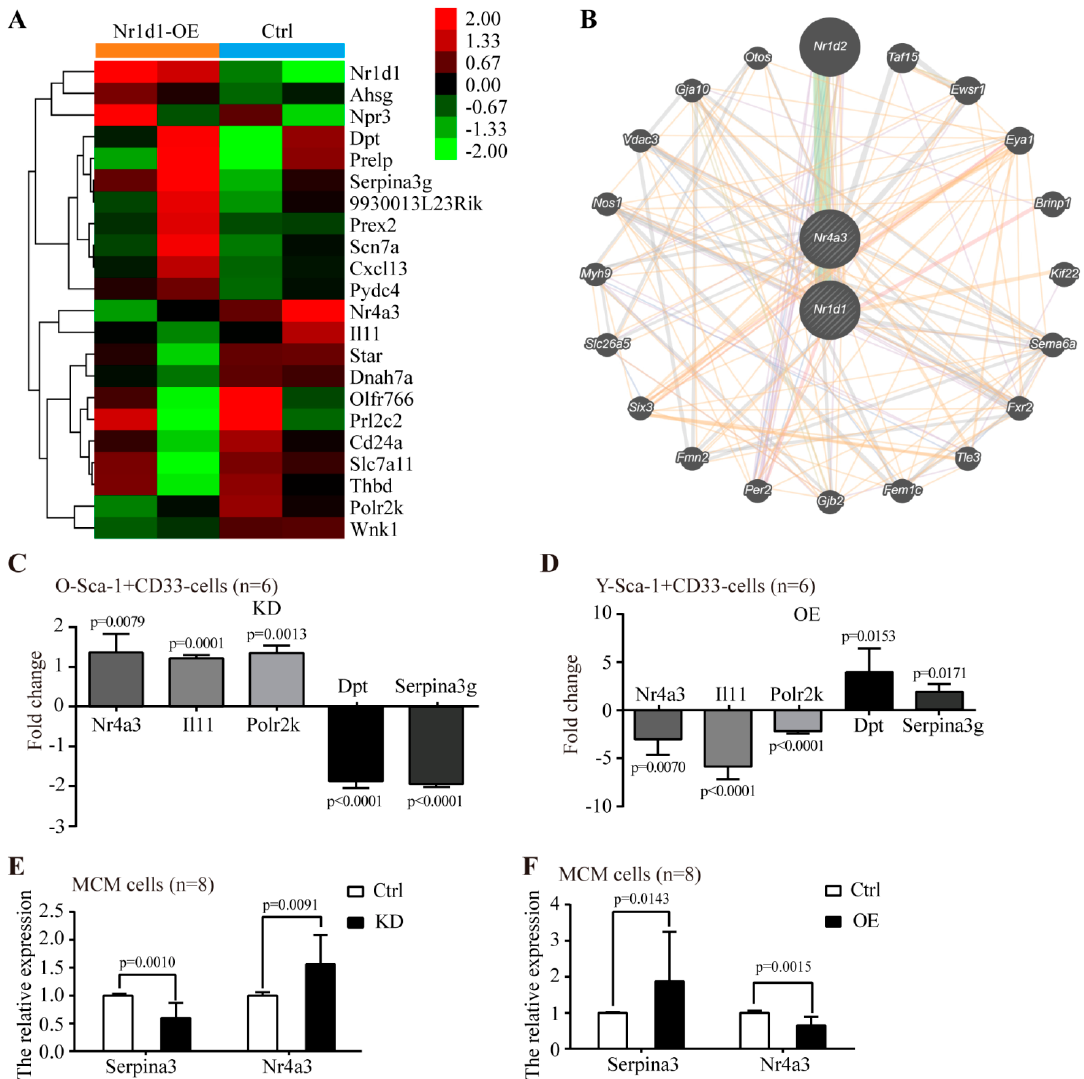
Figure 6. The effect of altered Nr1d1 expression levels on gene expression profiles. ( A ) the differ- entially expressed genes identified by a microarray in Young Sca-1 + CD31 − cells comparing the Nr1d1 -cDNA-infected cells and negative control. The tree was based on log2 transformation of normalized probe signal intensity using hierarchical clustering. Red: upregulated gene expression; Green: downregulated gene expression. Every sample was tested twice. A total of 22 differentially expressed genes were identified via pairwise comparison. ( B ) Interaction relation of differentially expressed genes by generadar (https: //www.gcbi.com.cn/gcanalyze/html/generadar/index, ac- cessed on 8 June 2020). ( C , D ) differentially expressed genes detected by real-time RT-PCR after Nr1d1 knockdown ( C ) and overexpression ( D ) in Sca-1 + CD31 − cells; data were from three indepen- dent experiments, and each experiment had two replicates ( n = 6). ( E,F ) Differentially expressed genes detected by real-time RT-PCR after Nr1d1 knockdown ( E ) and overexpression ( F ) in MCM. Expression levels were normalized by Gapdh , and expression levels in the negative control were used as a calibrator to calculate fold changes. Calculated difference change based on a mean of three independent experiments, and each experiment had at least two replicates ( n = 8). The ∆∆ CT values were subjected to unpaired Student’s t -test implemented using Prism software. Bars above and below the x -axis show genes that are up- or downregulated, respectively. All data in bar graph presented as mean ± SD, and two-way ANOVA was used as statistical analysis, and p < 0.05 was considered significant. Ctrl: control, KD: knockdown, OE: